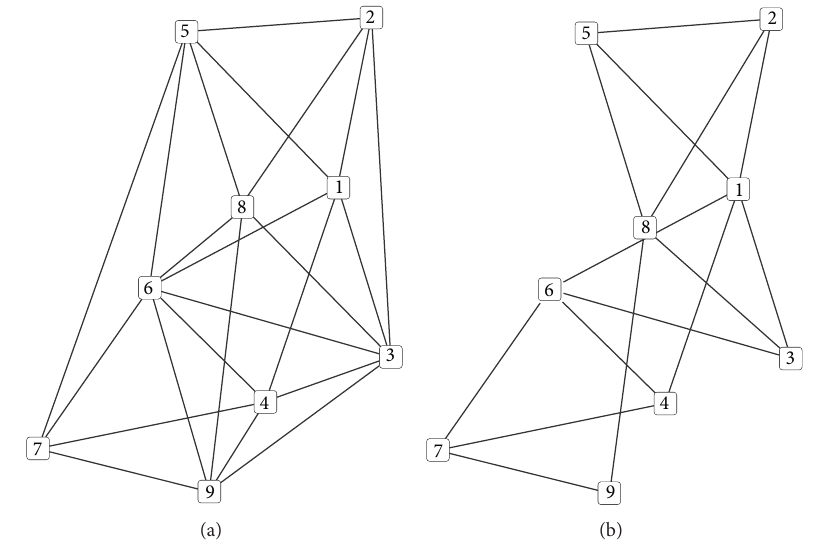
Figure 1: The topology structures of the networks for 9 nodes.